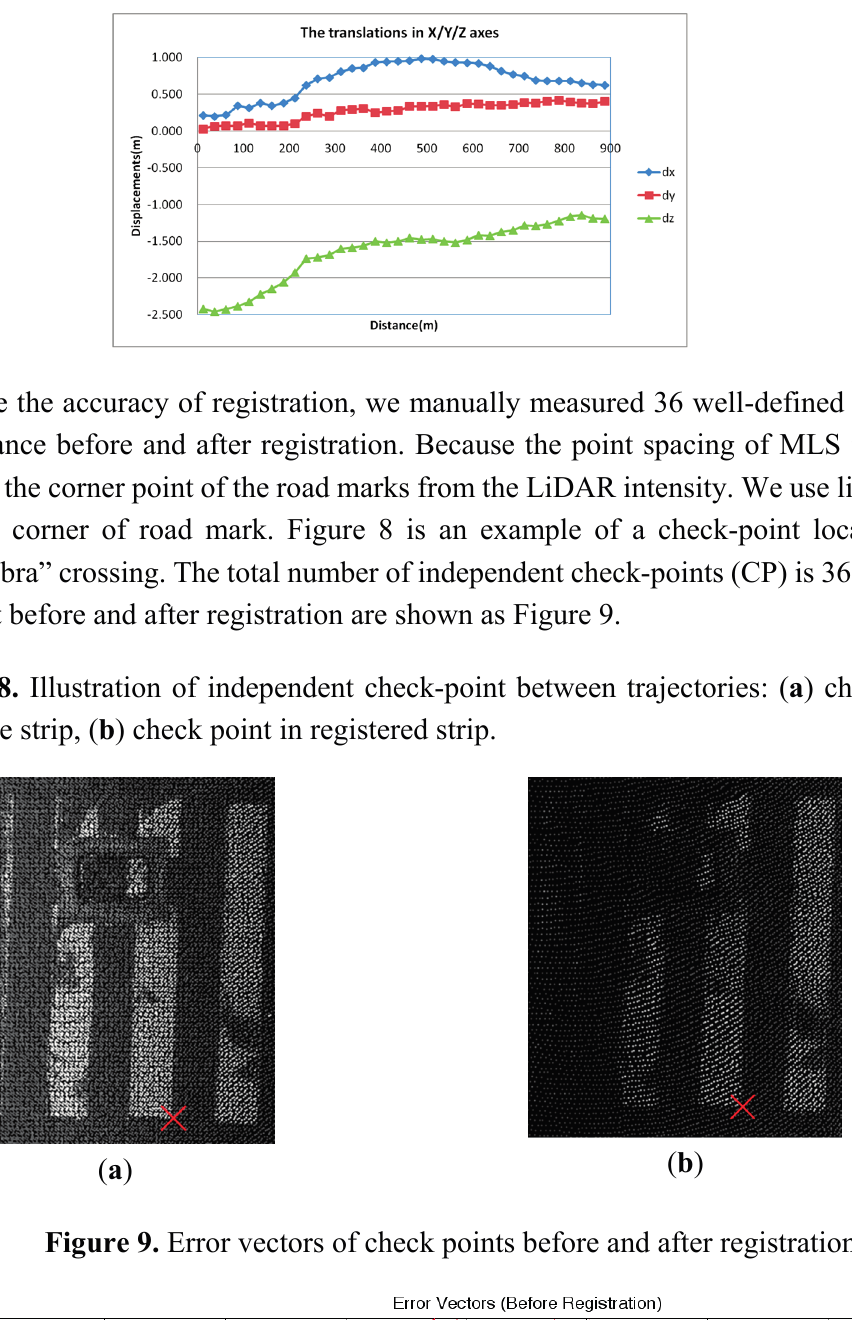
Figure 7. The translations in X/Y/Z directions (MLS/MLS registration).